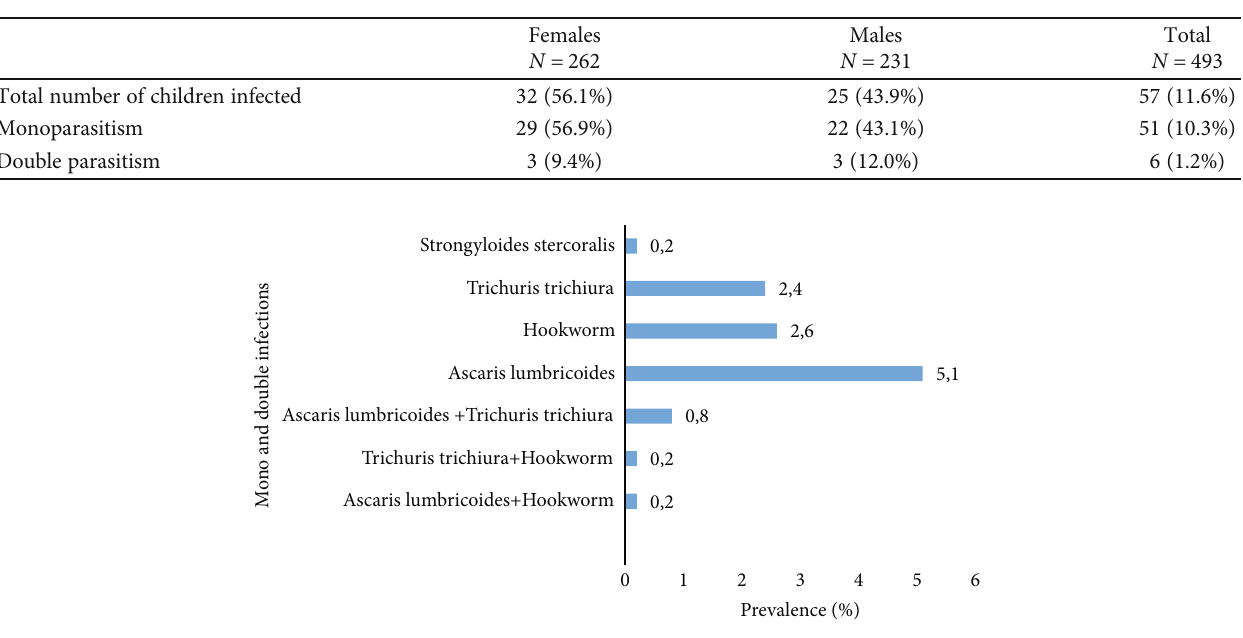
Table 6: Type of parasitism.